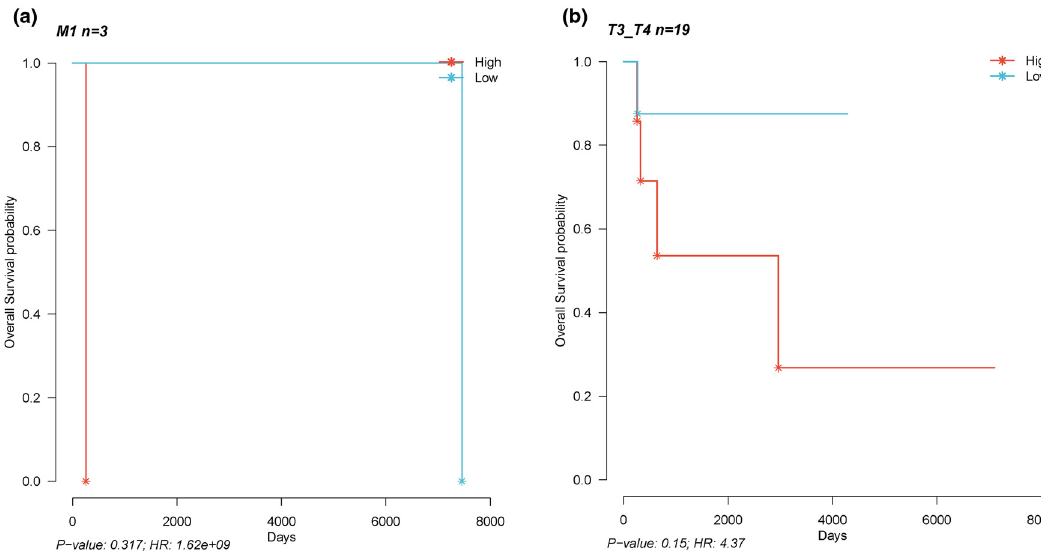
Figure A2: Kaplan – Meier survival analysis between high - risk and low - risk groups in patients in the group of patients with M1 ( a ) and the group of patients with T3 – T4 ( b )